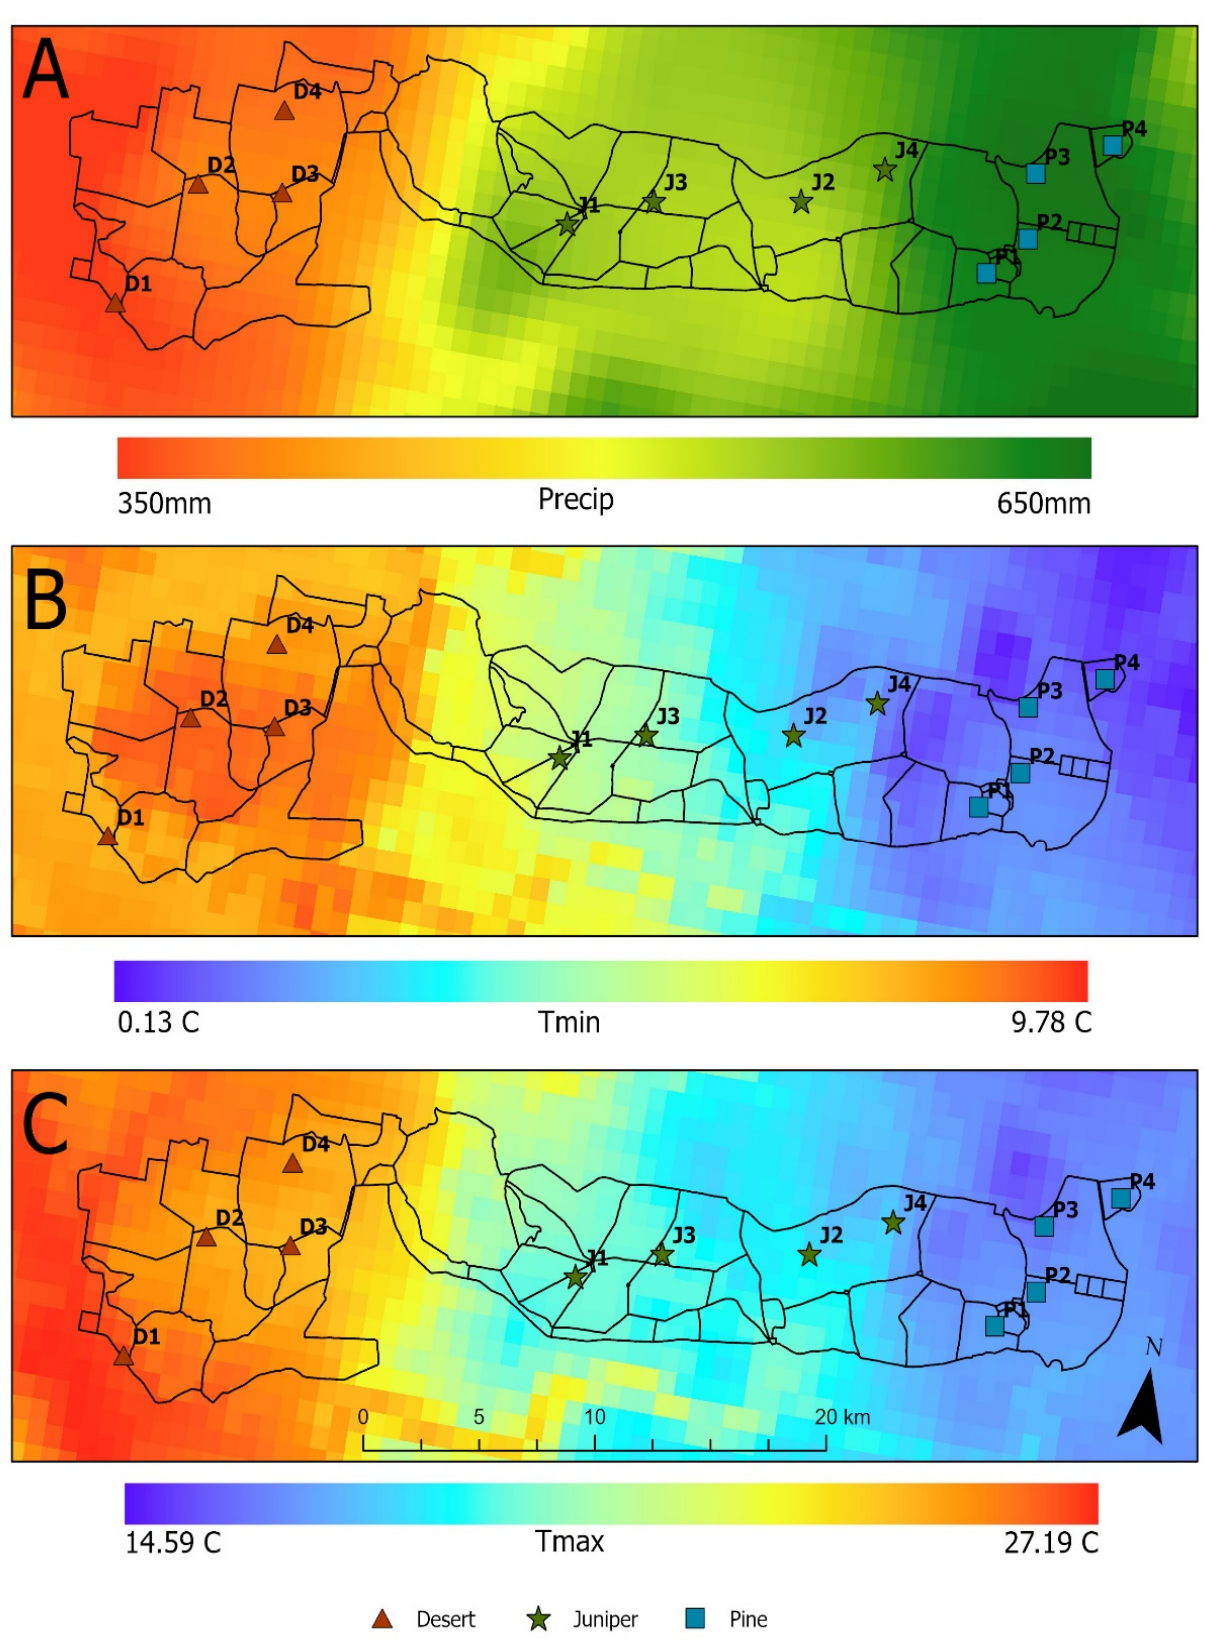
Figure 2. Long-term climate data (PRISM 2022) for the V Bar V Ranch, representing ( A ) Yearly average annual precipitation; ( B ) Yearly mean minimum temperature (Tmin); and ( C ) Yearly mean maximum temperature